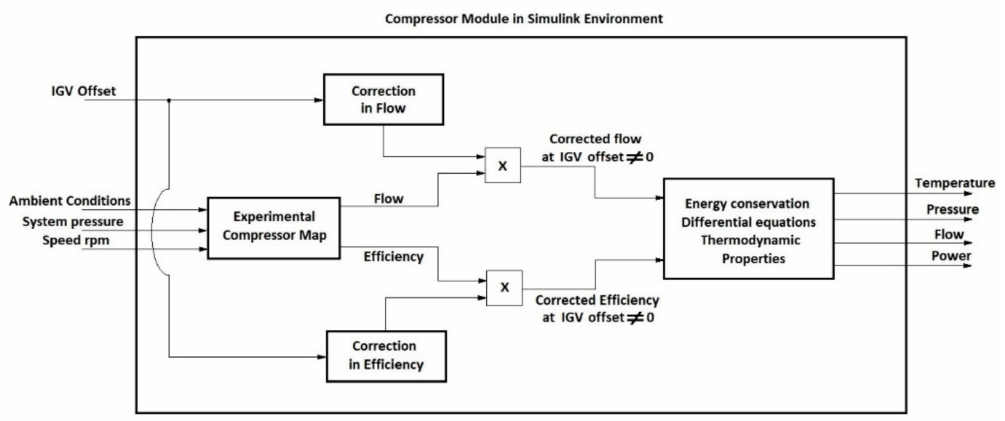
Figure 33. Correction in Flow and Efficiency with IGV offset correction